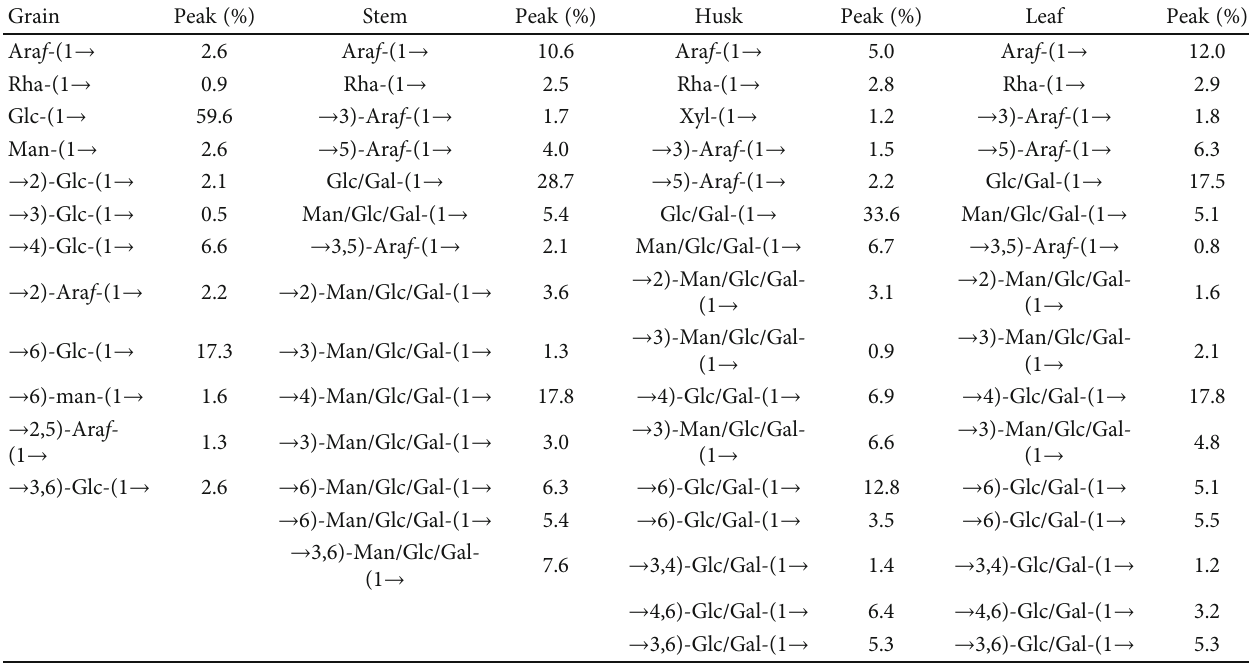
Table 3: Types of glycosidic bonds in fresh rice SDF at the medium-milk stage and corresponding peak areas.